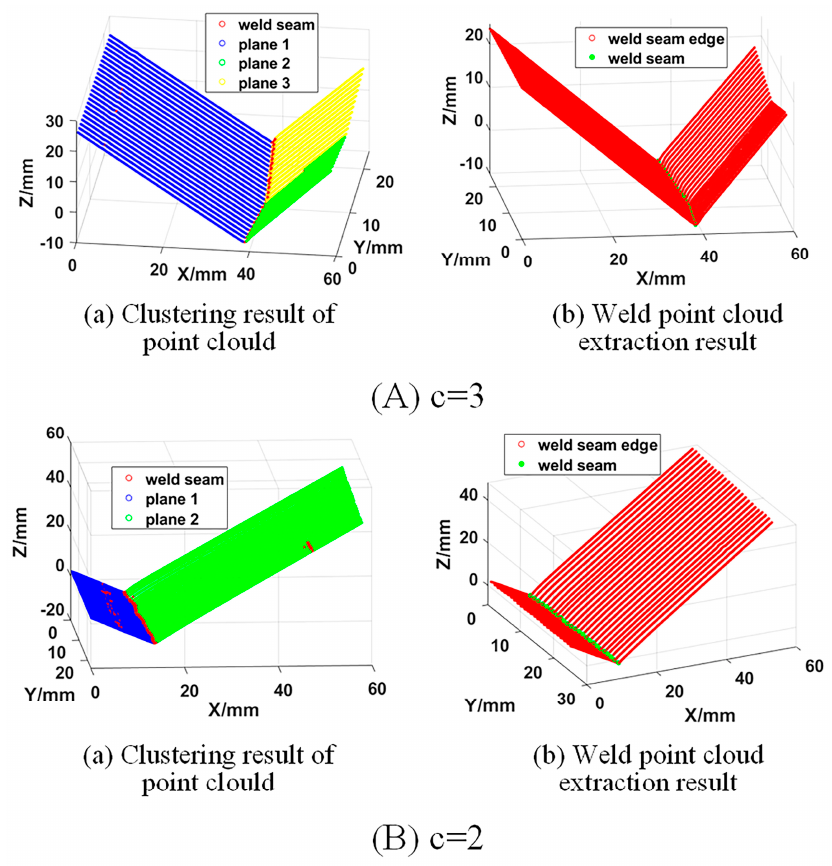
Figure 6. Weld point cloud extraction results; ( a ) Clustering result of point cloud; ( b ) Weld point cloud extraction result.